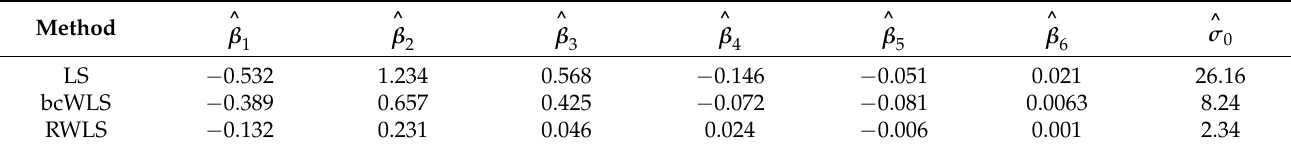
Figure 27. DTM disturbed by multiplicative error. The estimation and accuracy of the parameters are shown in Table 10. Table 10. The estimation and accuracy of DTM parameters.